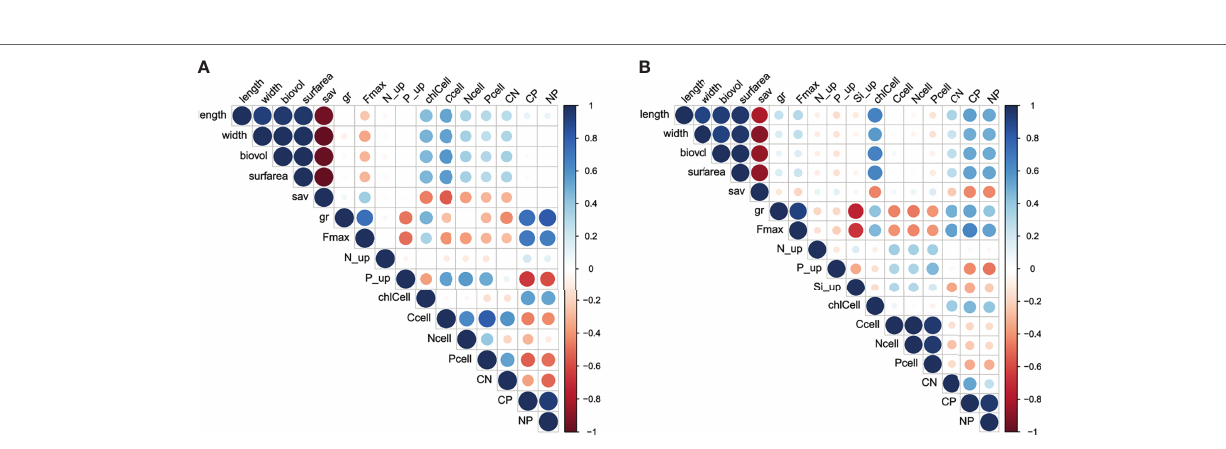
C:P ratios ( Figure 3A ). Strains grown in 0 psu treatment were characterized by large cells. Observations for 30 and 35 psu